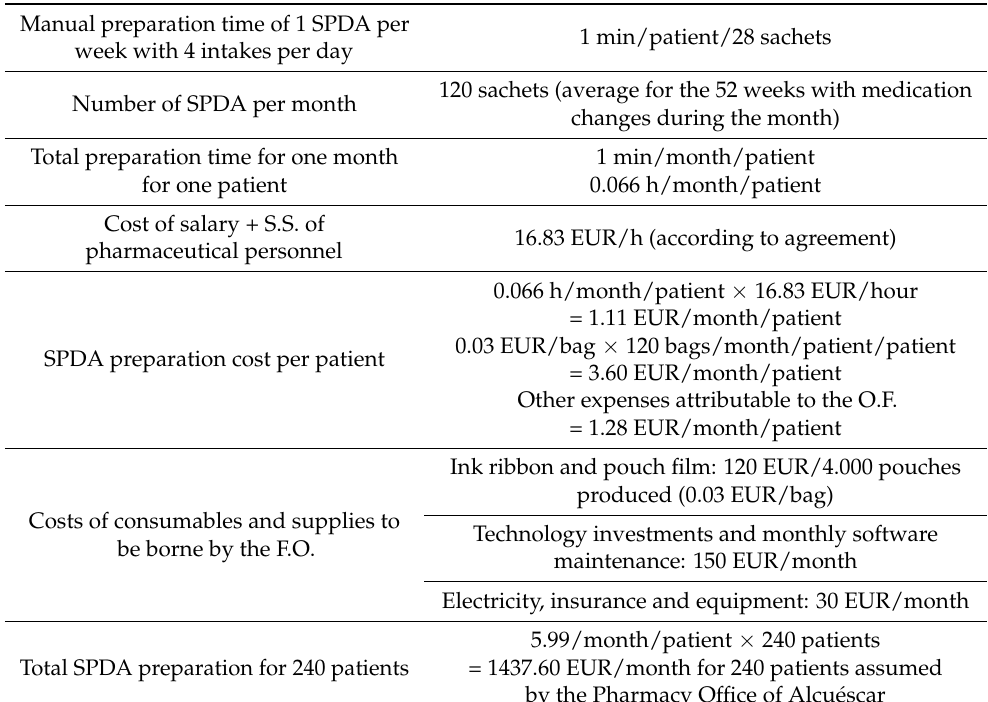
Table 3. Economic study for the automated preparation of weekly SPDA for 240 patients of the residential centre Ciudad Jard í